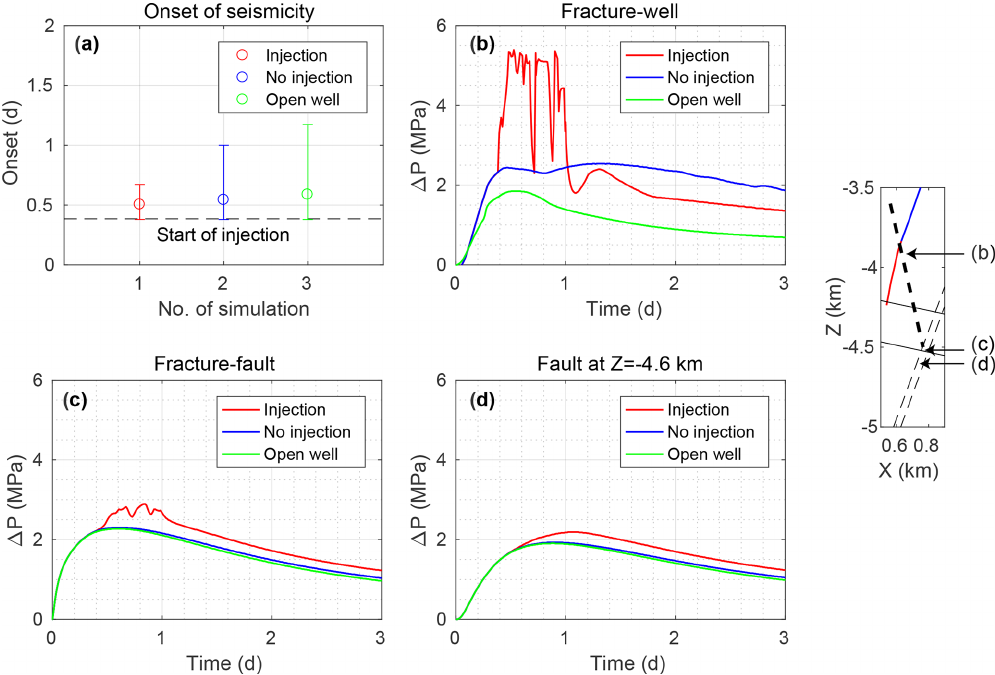
Figure 12. Comparison of scenarios with injection, without injection, and with an open well and no injection (1000 realizations each). (a) Onset of seismicity with error bars showing the first and third quartile around the median. The dashed line indicates the start of injection (ca. 0.4d). (b–d) Pressure change at (b) the fracture zone/well intersection, (c) the fracture zone/fault intersection, and (d) within the fault at a depth of 4.6km. The model sketch on the right shows the locations of the pressure monitoring